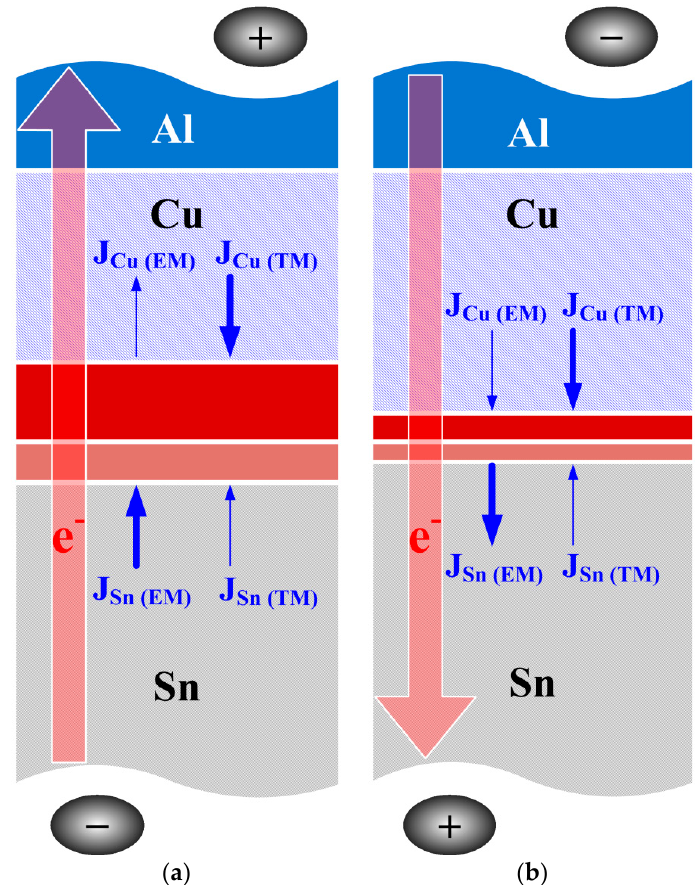
Figure 5. Growth mechanism of Cu 6 Sn 5 intermetallic compound (IMC) in the EP PV module at the Cu/Sn interface after ( a ) Ag-direction and ( b ) Al-direction biasing.